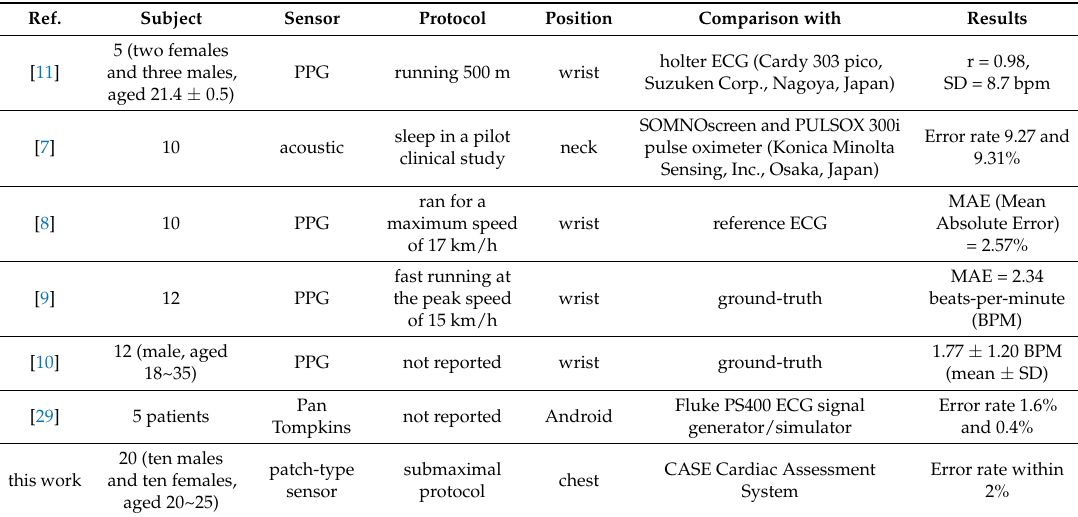
Table 4. Comparison with other works in the